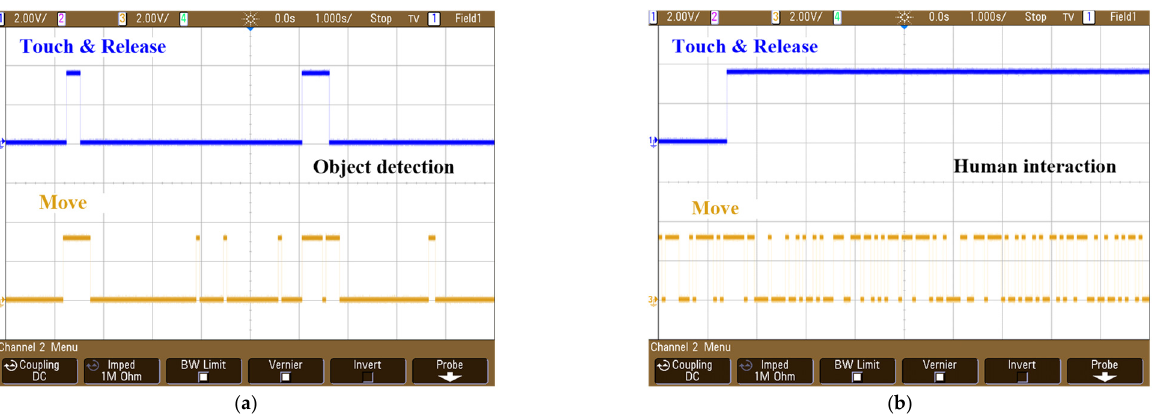
Figure 9. The MAF data of ( a ) movement interaction; ( b ) object detection; ( c ) human interaction while an object is on the electrode.